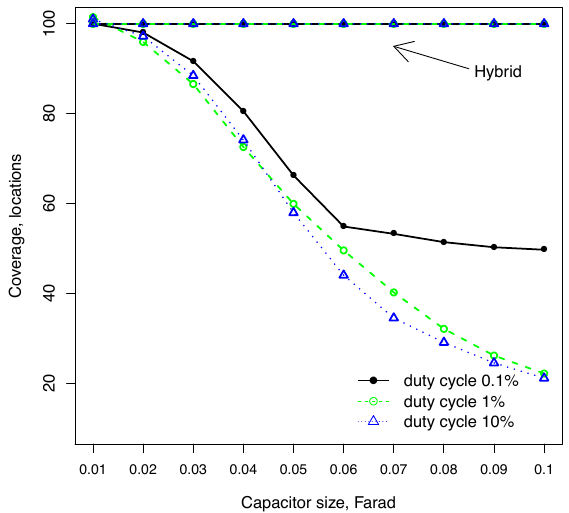
Figure 5. The number of unique locations served by a sensor in the fixed capacitor configuration decreases with capacitor size as the node is less likely to boot on a larger capacitor. The hybrid configuration provides nearly full